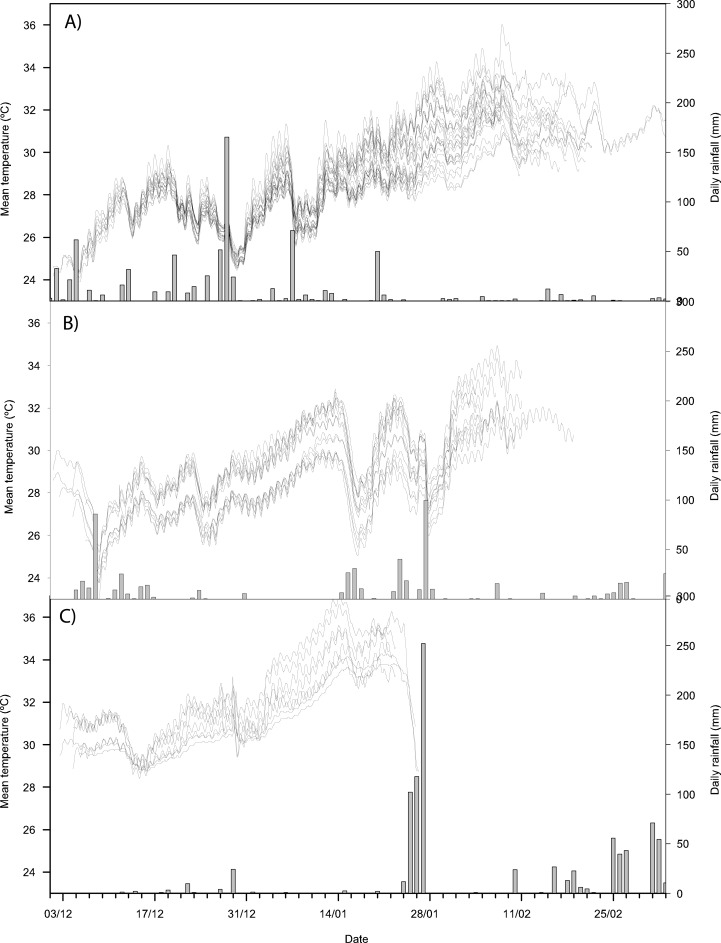
Daily rainfall (bars) and temperature profiles (lines) experienced by C. caretta nests in (A) 2010–2011 (n = 25), (B) 2011–2012 (n = 12) and (C) 2012–2013 (n = 7).Note that nests in the 2010–2011 and 2011–2012 seasons were obtained over several weeks, whereas nests in the 2012–2013 season were all obtained in the same week.